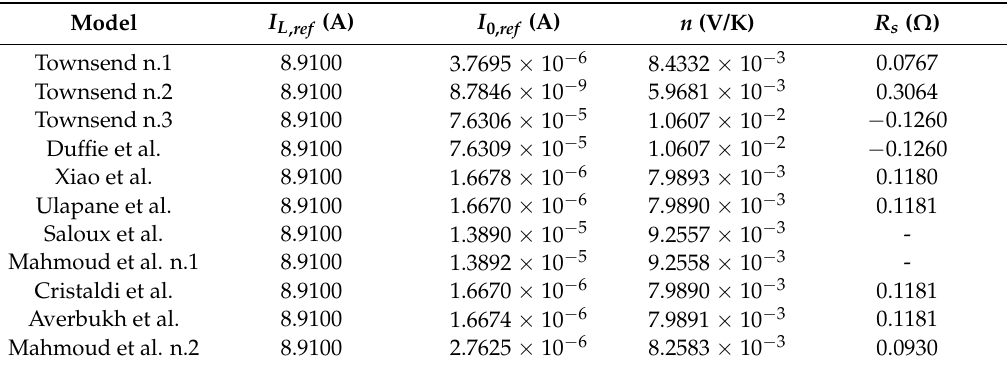
Table 3. Model parameters of the Kyocera KD245GH-4FB2 at the SRC.